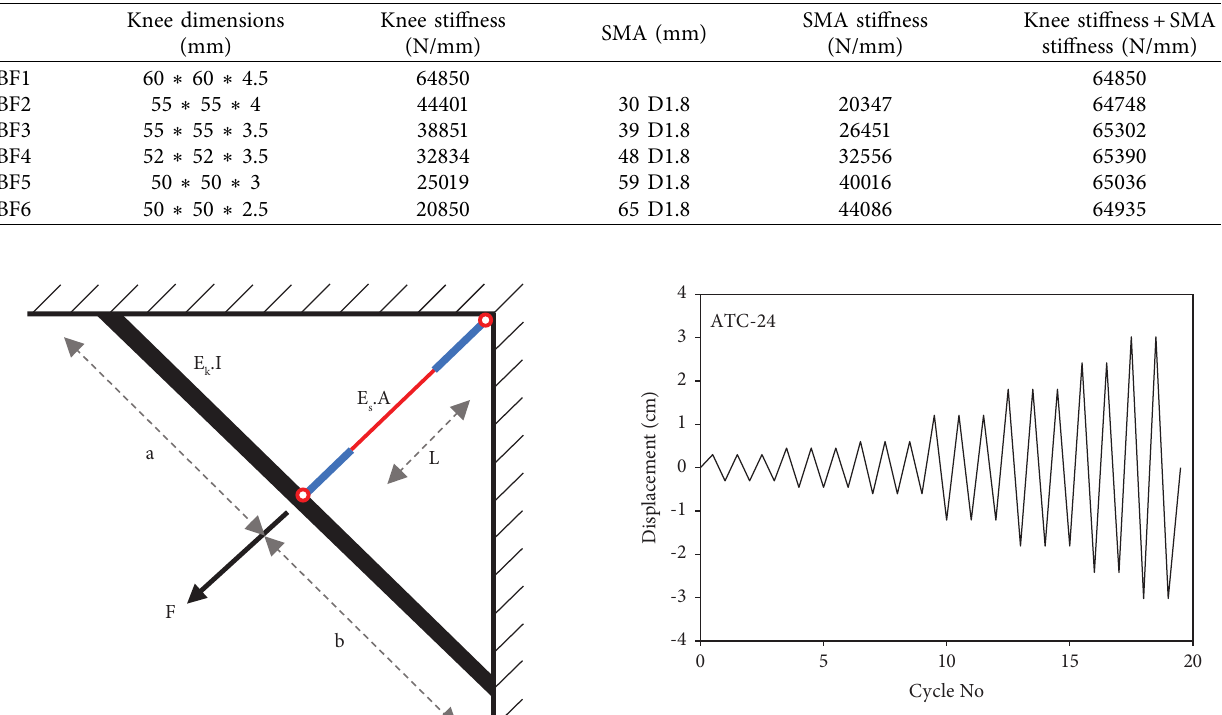
Figure 13: General confguration of KBF2 to KBF6. Table 2: Dimensional and mechanical properties of the knee element and SMA wires.